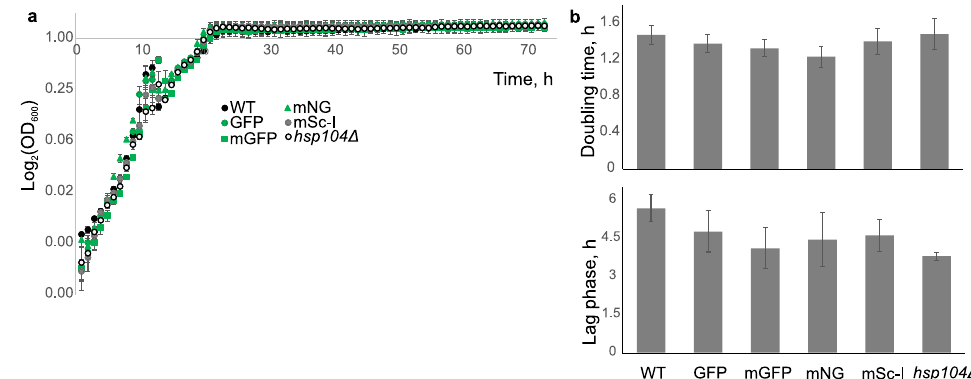
Figure 1. Growth characteristics of the BY4741 wild type (WT), cells expressing endogenous constructs Hsp104-GFP (GFP), Hsp104-mGFP (mGFP), Hsp104-mNeonGreen (mNG), Hsp104-mScarlet-I (mSc-I) and a deletion hsp104Δ strain. ( a ) Growth curves of yeast cultures. Each time point is a mean value of technical replicates of one strain. Error bars represent standard error of mean. ( b ) (top) Mean doubling time of different strains, (bottom) average length of the lag phase for different strains. Standard error of mean error bars. Data from one of three representative experiments is